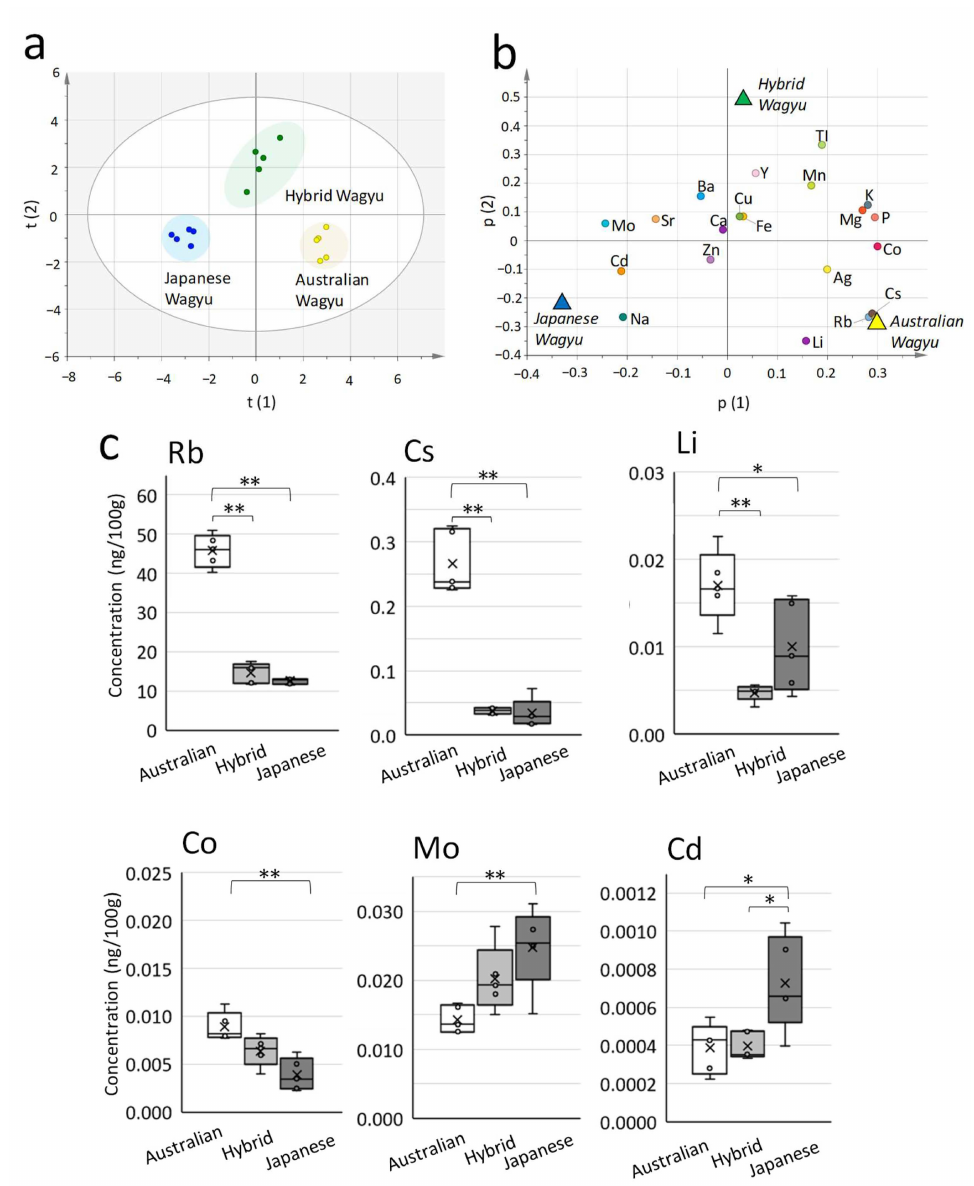
Figure 4. Comparison of Wagyu beef by elemental analysis. ICP–OES and ICP–MS were used to detect elements in beef. Samples were obtained from the rib-eye areas of the longissimus thoracis muscle (five Australian, Hybrid, and Japanese Wagyu each). ( a ) The score plot of orthogonal least-square discriminant analysis (OPLS-DA) reveals the relationships among Wagyu beef types regarding the musculus longissimus (scaling, UV). ( b ) Loading plot presenting the relationship between elements and each Wagyu type (R2X (1) = 0.309; R2X (2) = 0.149). Italicized letters indicate the location of each DA plot (triangles) obtained by OPLS-DA. ( c ) Box plot of the exclusive median and all plots, including outliers. The cross marks indicate the mean (n = 5). Significant differences are presented as follows: * p < 0.05 and ** p < 0.01 (Tukey’s test; Australian vs. Hybrid vs. Japanese Wagyu). Abbreviations: silver (Ag), barium (Ba), calcium (Ca), cadmium (Cd), cobalt (Co), cesium (Cs), bronze (Cu), iron (Fe), potassium (K), lithium (Li), magnesium (Mg), manganese (Mn), molybdenum (Mo), sodium (Na), phosphorus (P), rubidium (Rb), strontium (Sr), titanium (TI), yttrium (Y), zinc (Zn). However, molybdenum ( p < 0.01), and cadmium ( p < 0.05) were present at higher levels in Japanese Wagyu beef. No elements were present at significantly higher levels in Hybrid Wagyu than in Japanese and Australian Wagyu